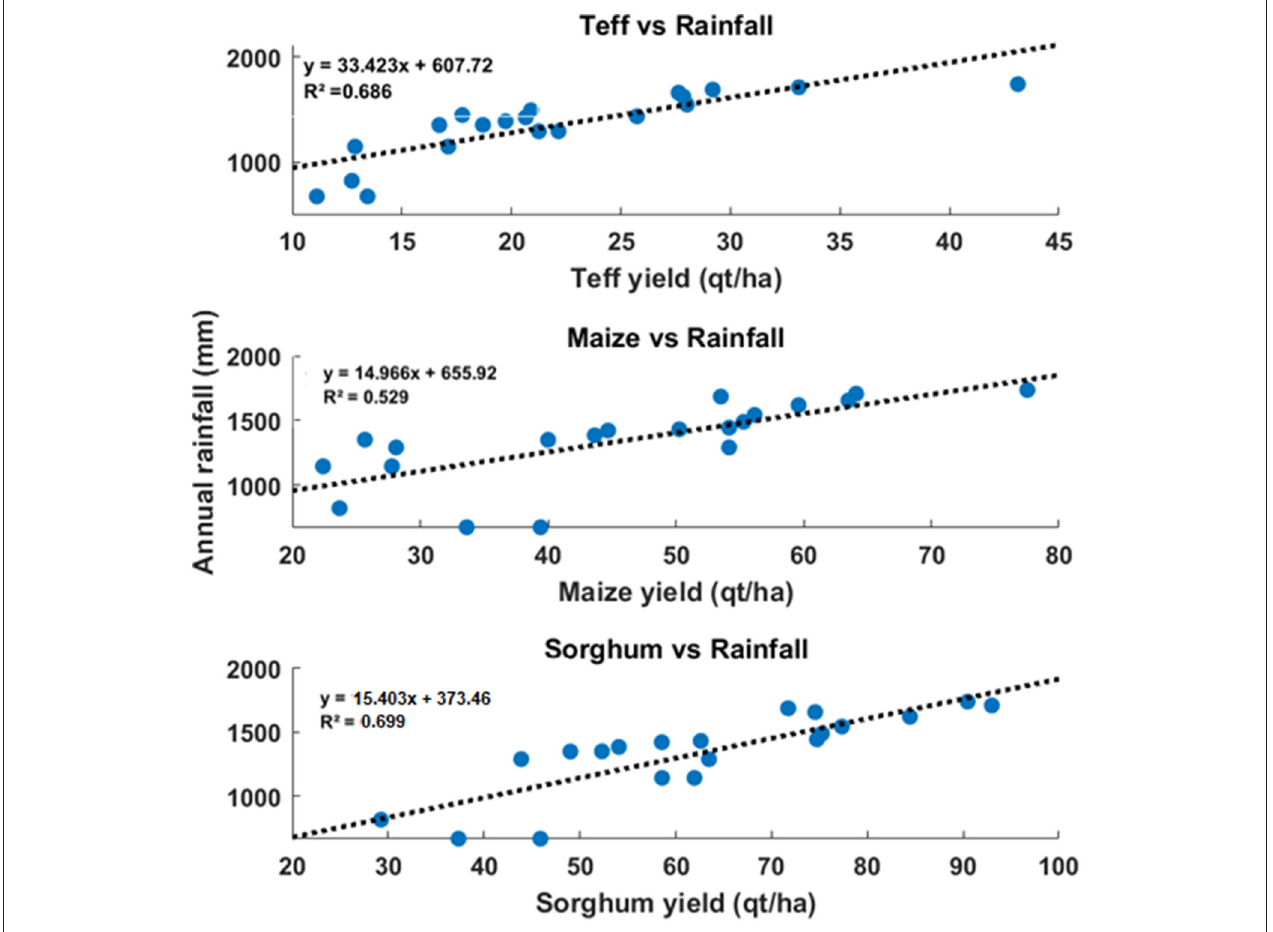
FIGURE 7 | Scatter plots of the yields of dominants crops vs. annual rainfall amounts. Yields rise rainfall, suggesting rainfed